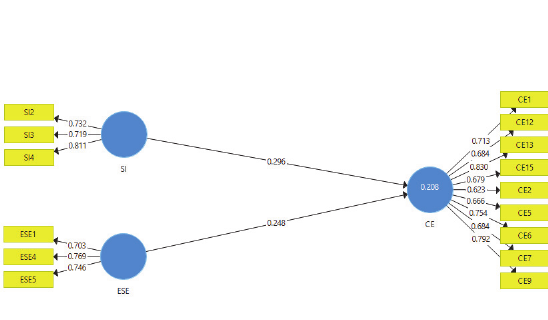
Fig. 1. Measurement